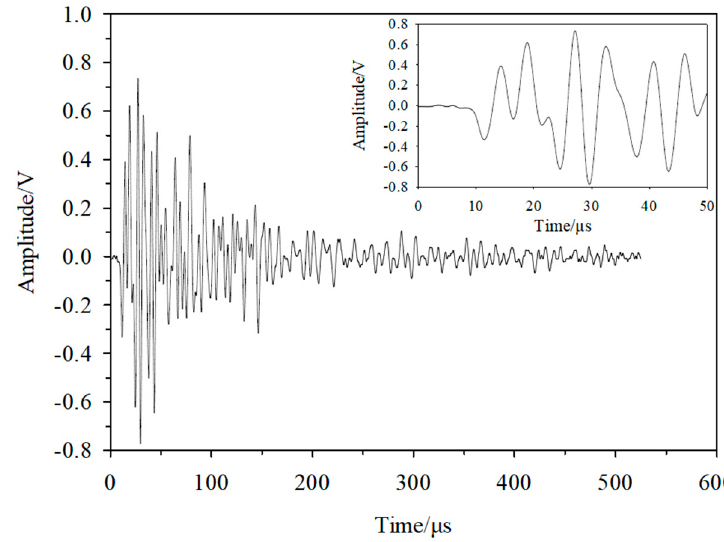
Figure 6. Signal waveform of the direct measurement of t 0 . Table 1. Testing time for P-wave of POM